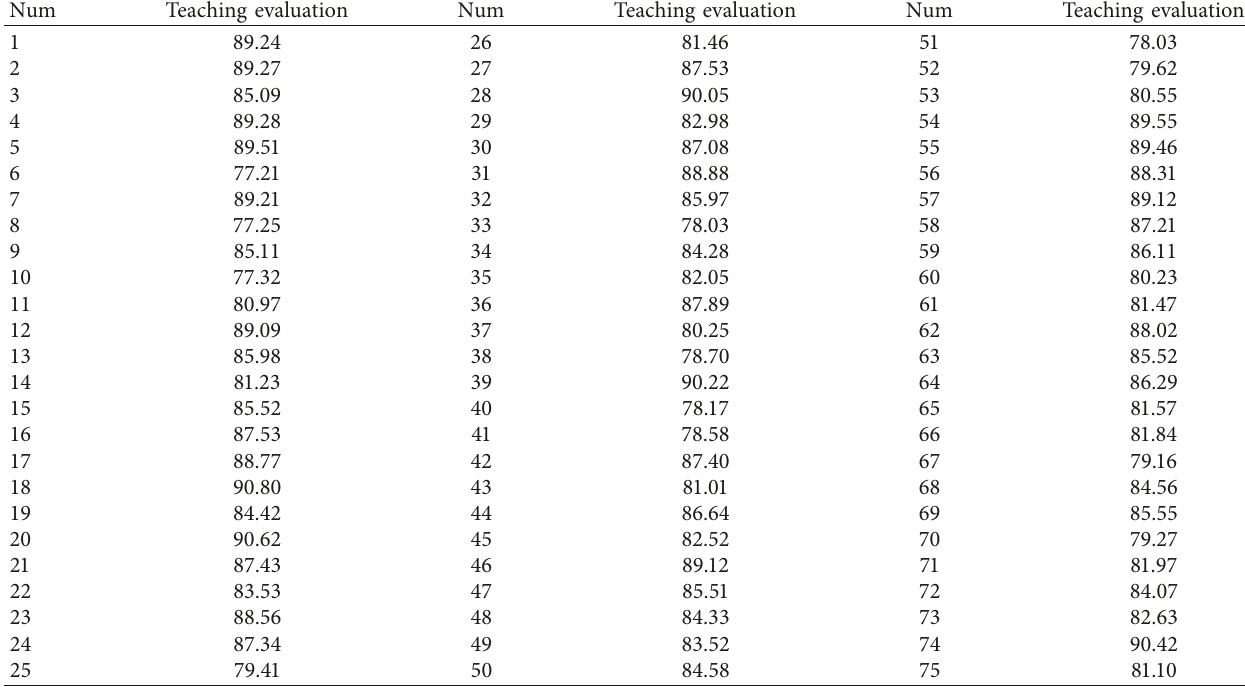
Table 3: The teaching improvement effect of the hierarchical retrieval model of digital English teaching information based on ontology.